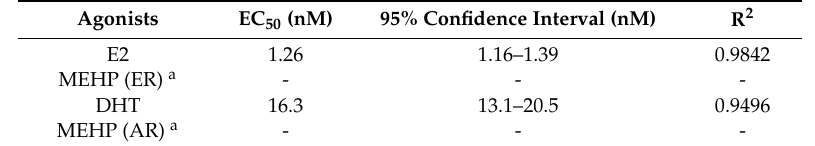
Table 1. EC 50 values with 95% confidence intervals and R 2 for agonist standards and MEHP.